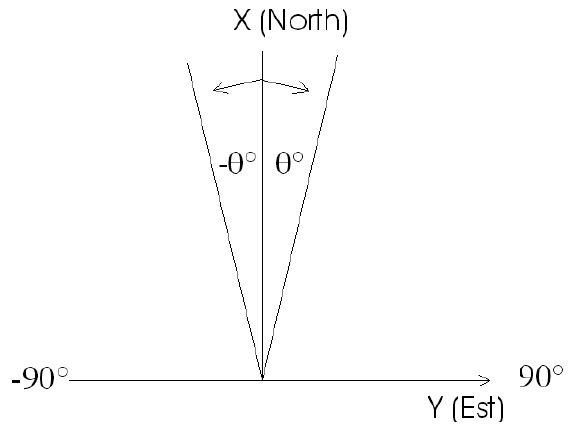
Figure 12. Scheme of the orientation angle.